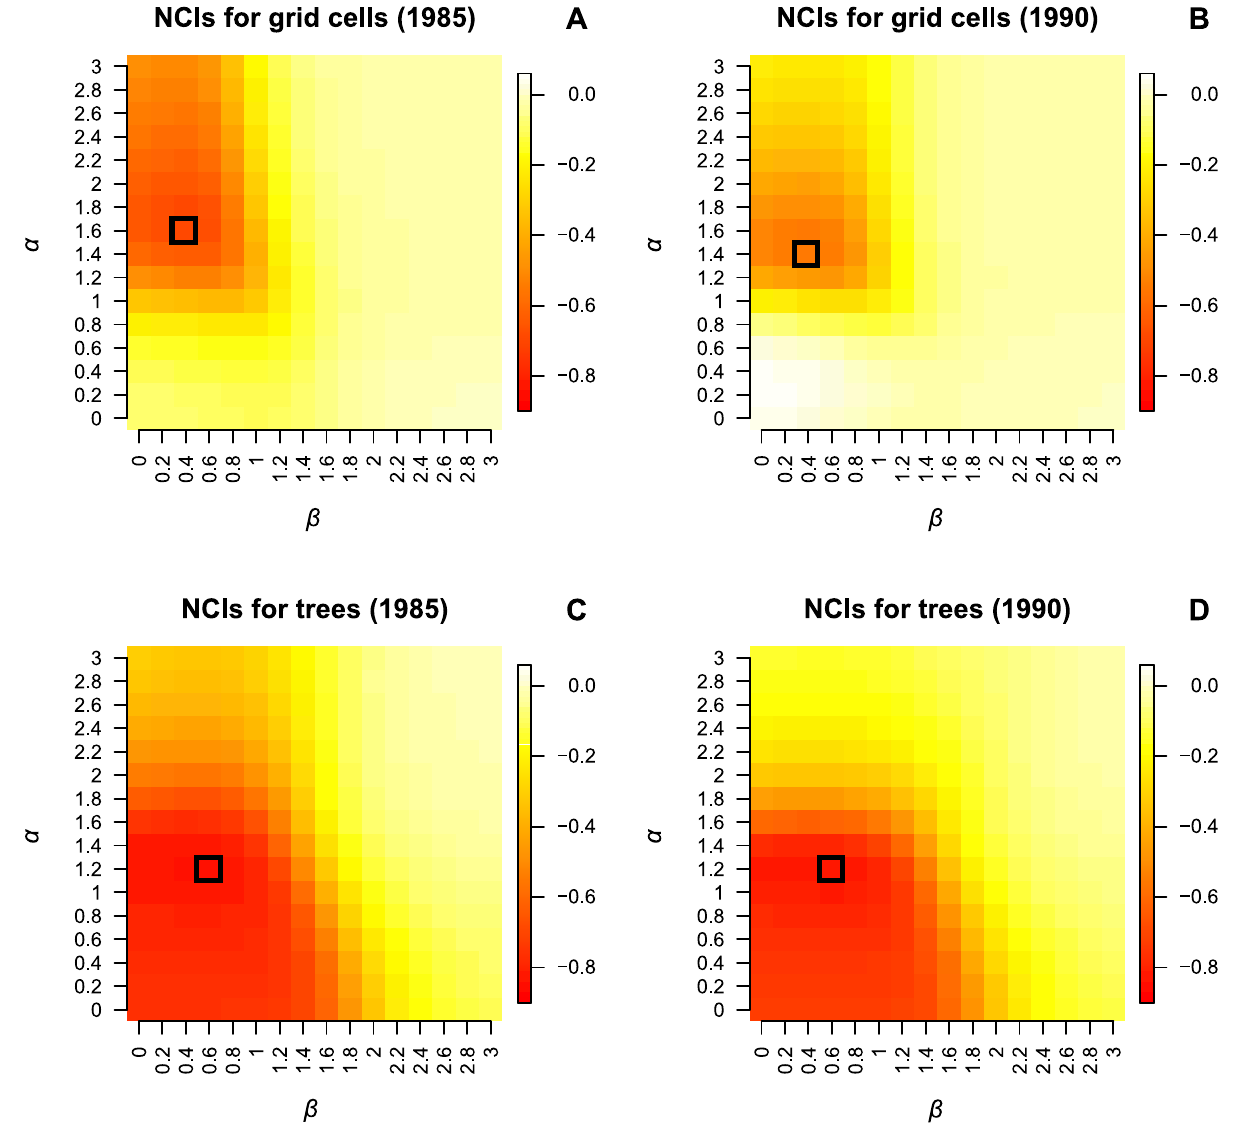
Figure 1. Correlation between log(canopy index) and neighborhood competition indices with different values of a and b . The correlation is based on the canopy index and neighborhood competition indices (NCIs) for 16,544 5 6 5 m grid cells (A, B) and for 135,788 (C) and 139,625 trees (D) in the BCI forest plot. For grid cells, the highest correlation was achieved with a =1.6 and b =0.4 in the first, and a =1.4 and b =0.4 in the second census (highlighted). For individual trees, the highest correlation was achieved with a =1.2 and b =0.6 (highlighted) in both censuses. Colors indicate Pearson’s r .